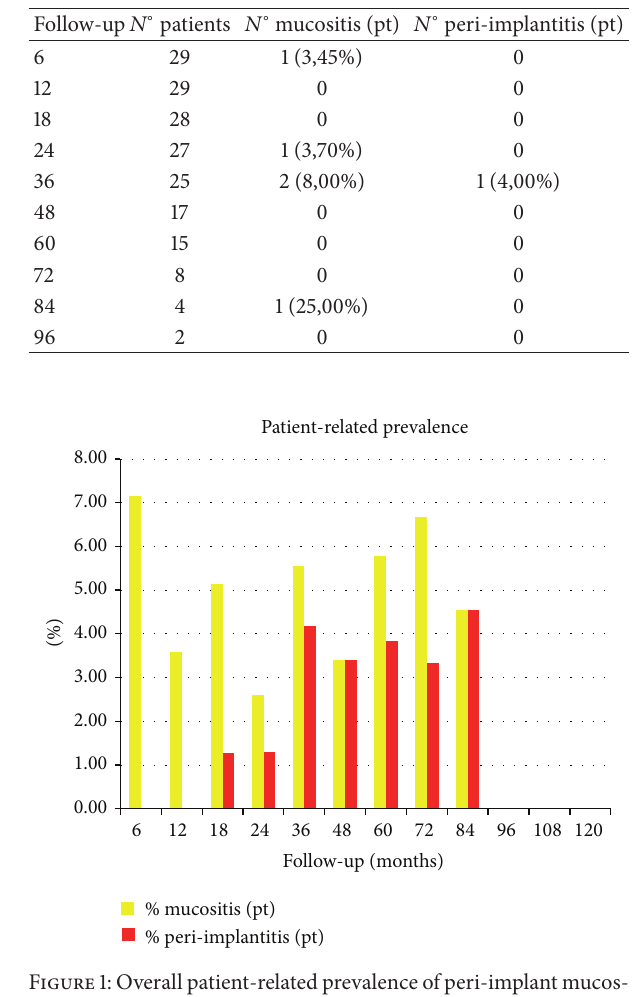
Figure 1: Overall patient-related prevalence of peri-implant mucos- itis and